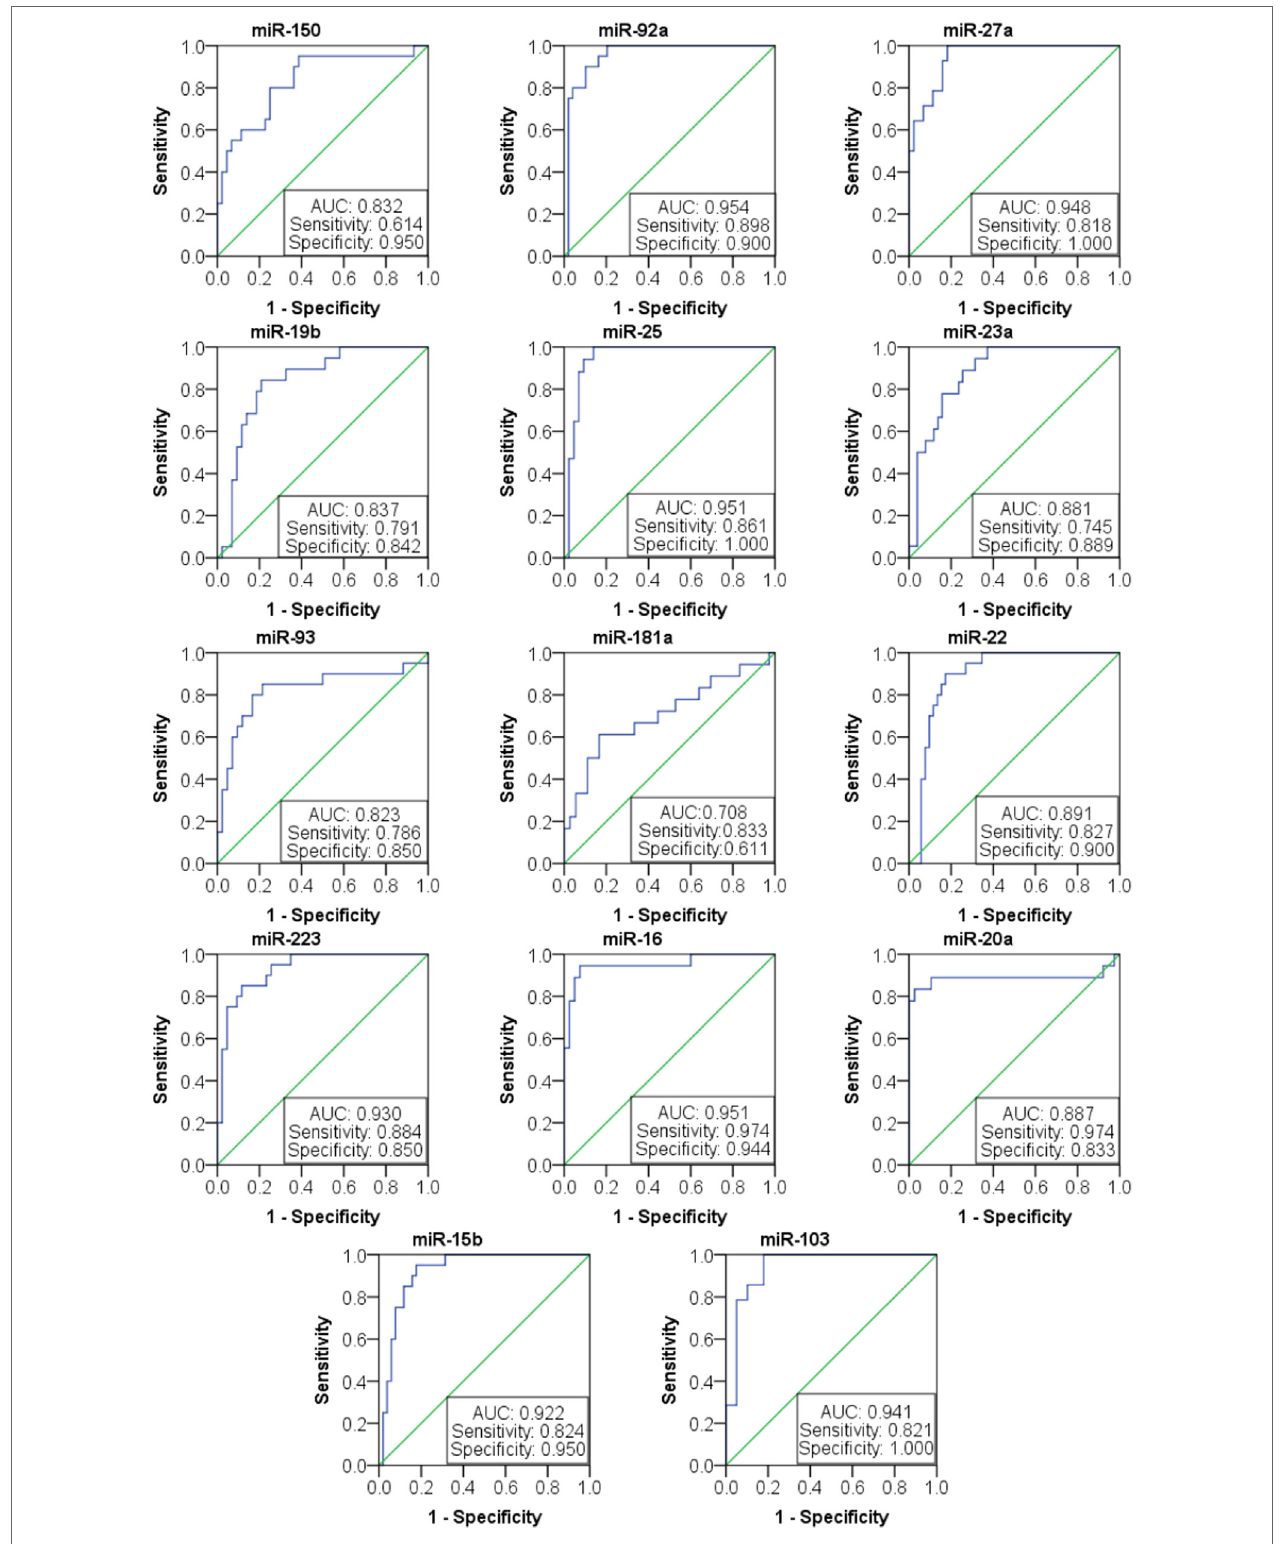
FigUre 3 | Receiver operating characteristic (ROC) curve of 14 microRNAs (miRNAs) for systemic lupus erythematosus (SLE) diagnosis from healthy control. The areas under curve (AUC) for miRNAs are shown in Figure 3 and Table 4 , respectively. The diagnostic sensitivity for SLE difference from healthy people was 0.61~0.97 and the specificity was